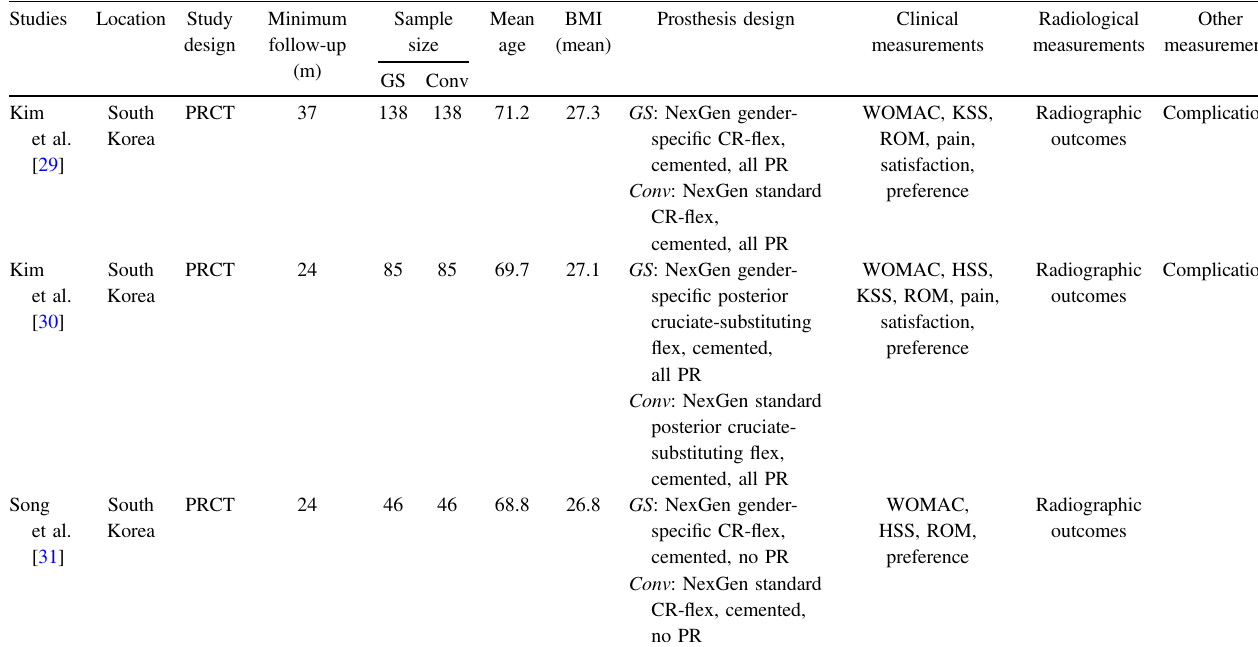
Table 1. Characteristic of the